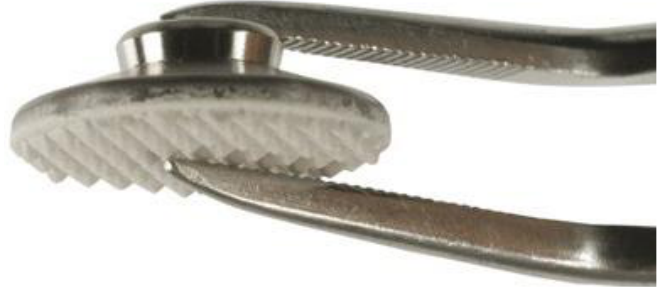
Figure 1. An Onplant device (Nobel Biocare, Gothenburg, Sweden).